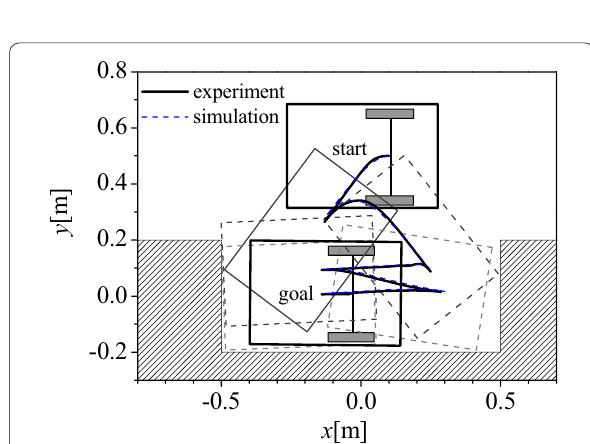
Fig. 10 Trajectory in the parallel-parking experiment when α is switched as α